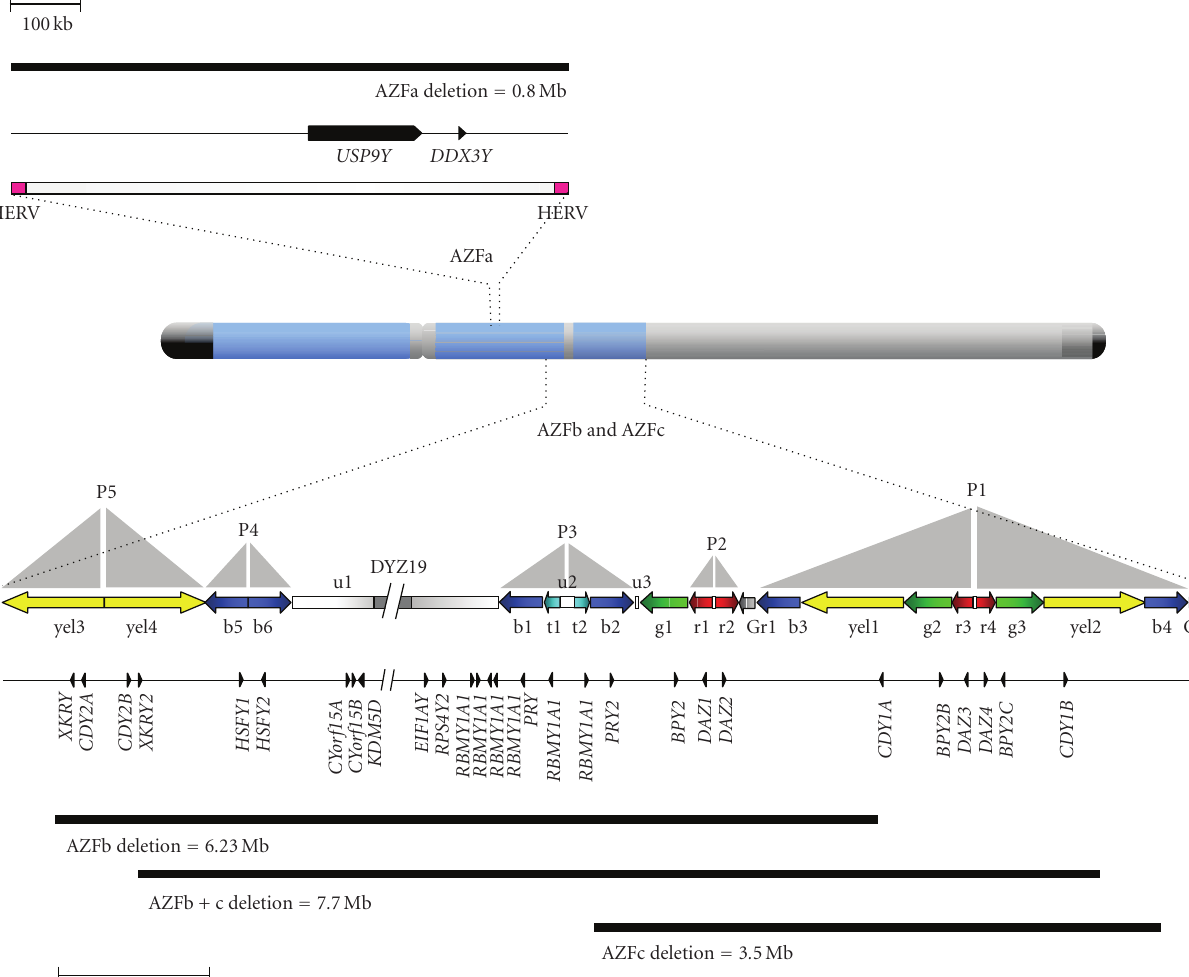
Figure 2: Schematics on the genomic architecture and gene content of the reference AZFa, AZFb and AZFc regions of the human Y chromosome. Central ideogram depicts the Y chromosome with the pseudoautosomal regions represented by black boxes at the tips of the chromosome (PAR1 and PAR2, respectively), the three heterochromatic domains indicated in grey (the centromeric region, the satellite repeat array embedded in Yq euchromatin, and the Yq heterochromatic block) and euchromatin in blue. The genomic organization of the AZFa region is depicted in the top half of the figure. This region maps from approximately 12.9 to 13.7 Mb of the chromosome and contains two single copy genes: USP9Y and DDX3Y (represented in scale by two oriented triangles indicating 5 (cid:3) -3 (cid:3) polarity). AZFa is flanked by two human endogenous retrovirus (HERV) elements that mediate the occurrence of AZFa deletions via non-allelic homologous recombination. The genomic organization of the reference AZFb and AZFc regions, as defined by the occurrence of specific deletion patterns, are depicted in the bottom half of the figure. AZFb maps from approximately 18 to 24.7 Mb of the chromosome and AZFc from ∼ 23 to ∼ 26.7 Mb. Both regions feature multiple stretches of ampliconic sequences, represented by block arrows. The amplicons are divided in six colour-coded sequence families (yellow, blue, turquoise, green, red and grey) with each unit being coded according to a binomial notation indicative of family type and copy number [20]. The size and orientation of the arrows is representative of amplicon length and polarity, respectively. The organization of amplicons in symmetrical arrays of contiguous repeat units (palindromes P1 to P5) is represented by large triangles. AZFb is defined by the P5/proximal P1 deletion (yel3/yel1), and AZFc by the b2/b4 deletion. Single copy domains are depicted in white and the DYZ19 satellite repeat in grey. The spacers between the two red amplicon clusters are identical between them. Transcription unit allocation to these regions is observable below the architecture map. For a more precise mapping of the genetic determinants please consult Figure